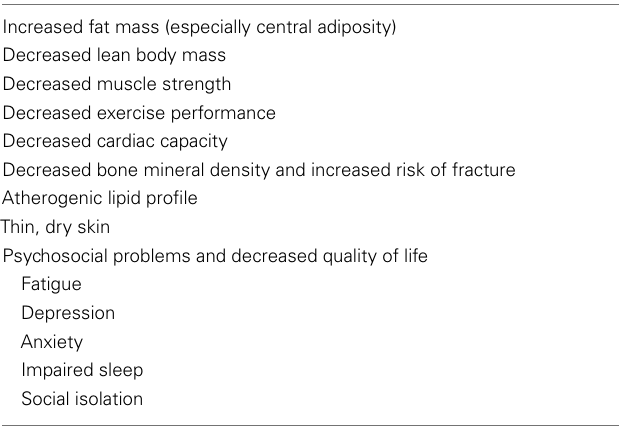
Table 1 |Adult growth hormone deficiency quality of life assessment (QoL-AGHDA) (reproduced from McKenna et al., 1999).